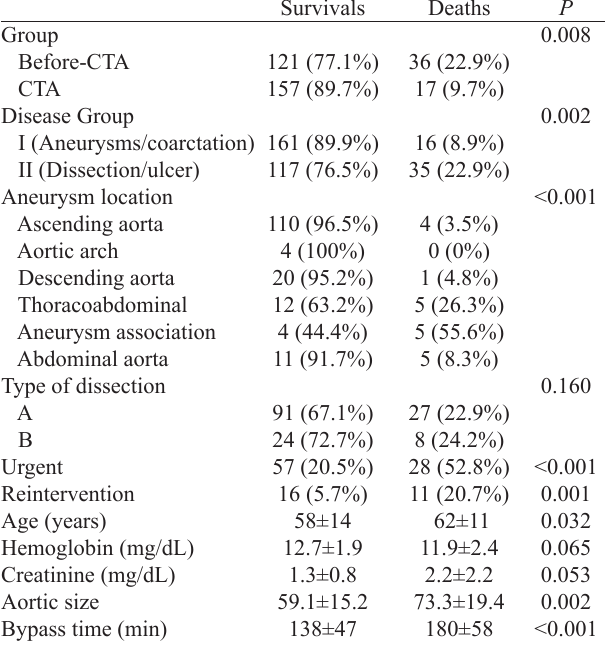
3. Univariate analysis of baseline characteristics and operative variables associated with in-hospital mortality after aortic surgery.